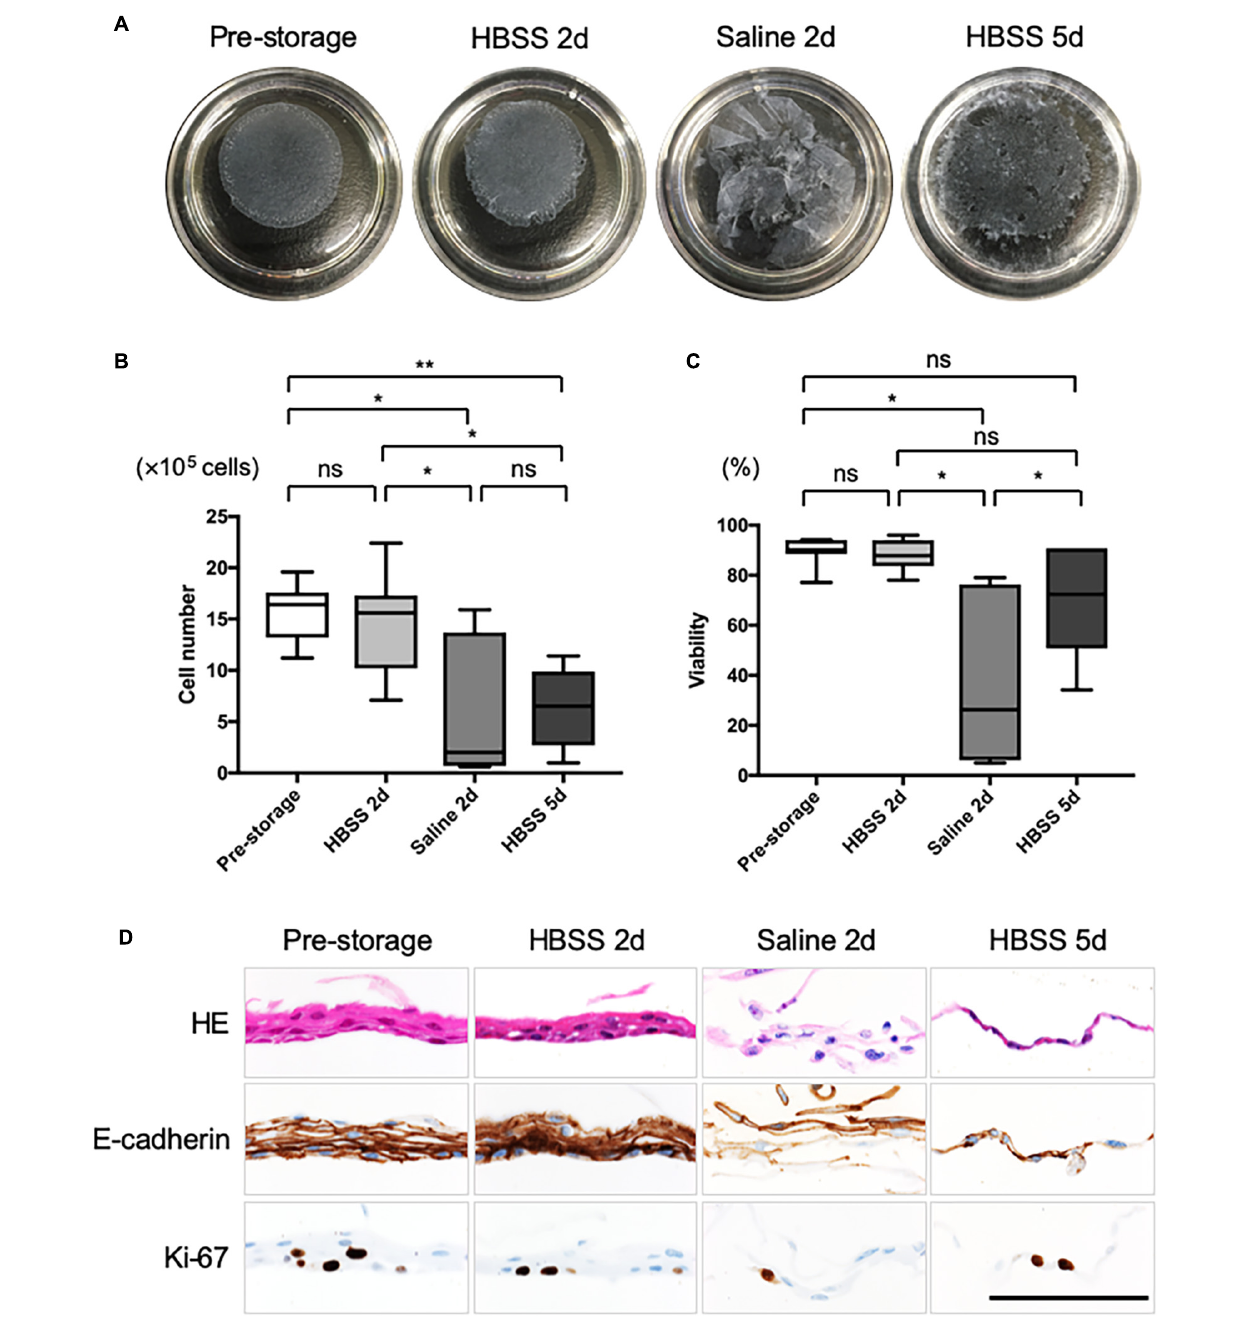
FIGURE 2 | Quality evaluation of post-storage cell sheet. (A) Representative images of the cell sheet before and after preservation. (B) Cell number was determined from a harvested cell sheet derived from nasal mucosal tissues ( n = 5) under each condition. (C) Cell viability was determined from a harvested cell sheet obtained from nasal mucosal tissue ( n = 5) under each condition. (D) Hematoxylin and eosin (HE) staining and immunohistological evaluation of the expression of E-cadherin and Ki-67 in pre- and post-storage nasal tissues. Scale bar = 100 µ m. * P < 0.05; ** P < 0.01; ns, not